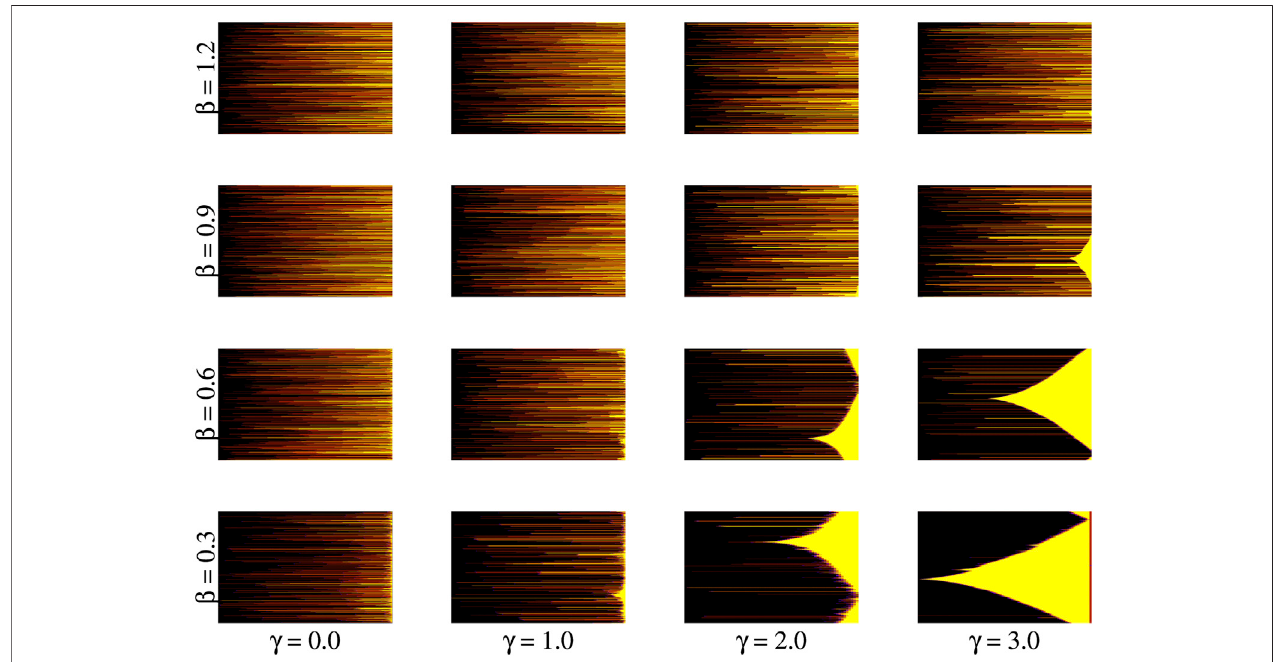
FIGURE 5 | The fi gure shows spatial correlation during a failure process when β varies between 0.3 and 1.2 and c varies between 0 and 3. Nucleating failure is observed for high c and low β . The spatial correlation reduces as c is decreases (pushes the model towards MF limit) or β is increased.